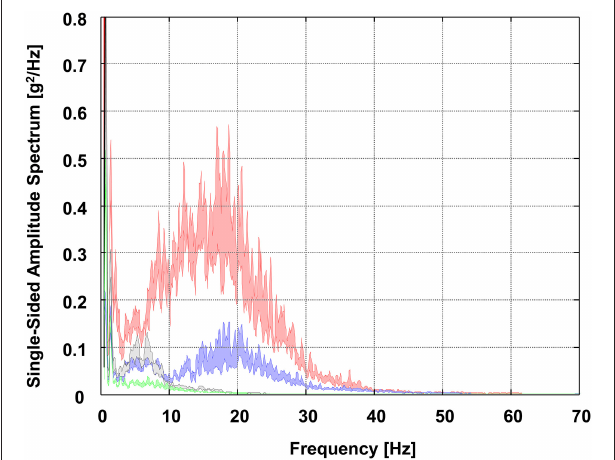
FIGURE 4 | Group average power spectral density (PSD) curves of all segments in SL skiing visualized as the area of uncertainty around the estimate of the mean ( ± SE). Red, right shank sensor; blue, right thigh sensor; gray, sacrum sensor; green, sternum sensor.